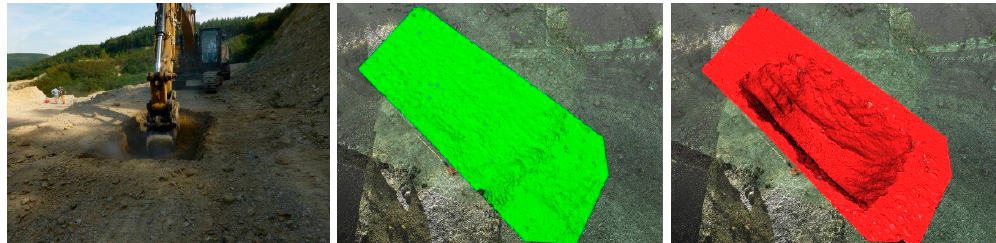
Figure 6. Collection of the large-scale sample—Probe 1. Before excavation—green left, after excavation—red right.